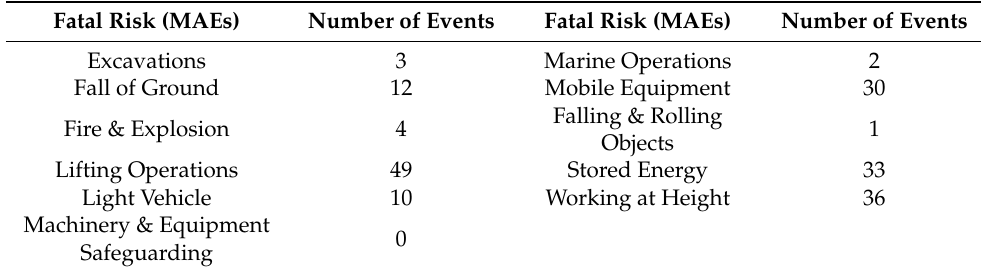
Table 2. Number of L4/L5 Event Reports by category.